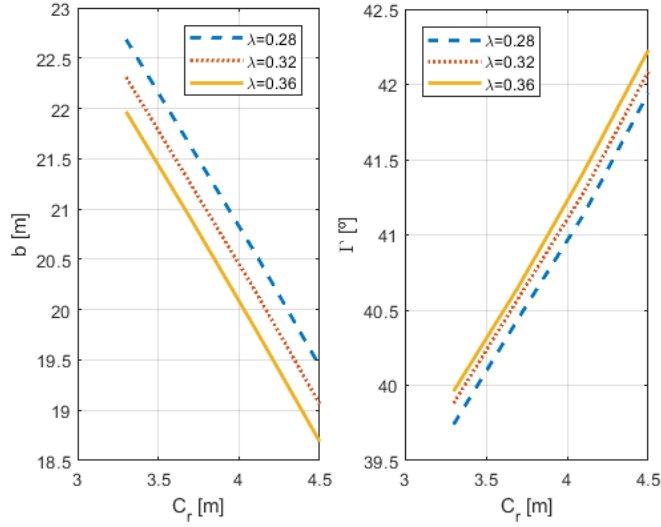
Figure 6. Design variables combination resulting of intersecting the constraints associated with the static stability conditions, both longitudinal and